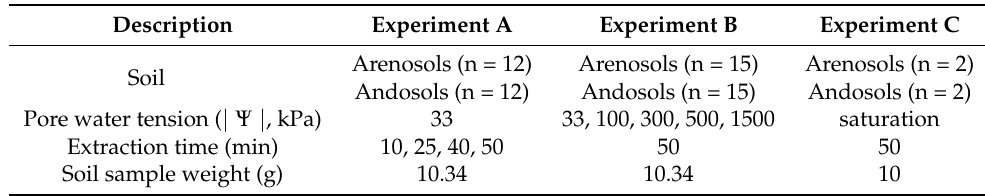
Figure 2. ( a ) Schematics for sample preparation ( b ) Schematics for cryogenic vacuum extraction ( c ) Detail of Vacutainer with screw cap and silicon septa ( d ) Detail of needles attached to stainless steel capillaries ( e ) Cryogenic extraction setup. Table 2. Description of experiments A, B and